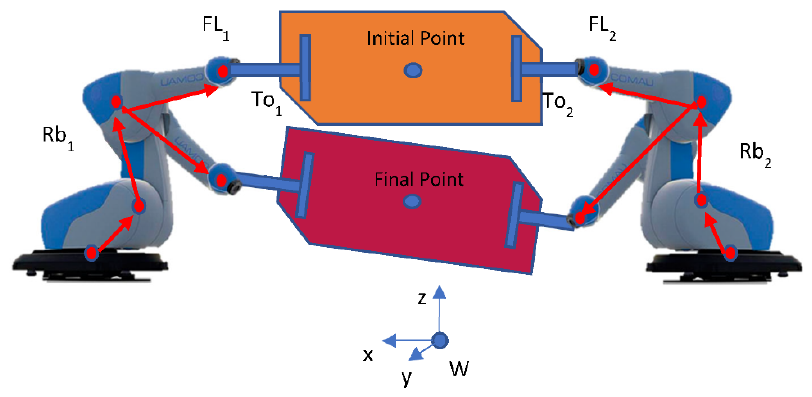
Figure 10. Reference World and center part.